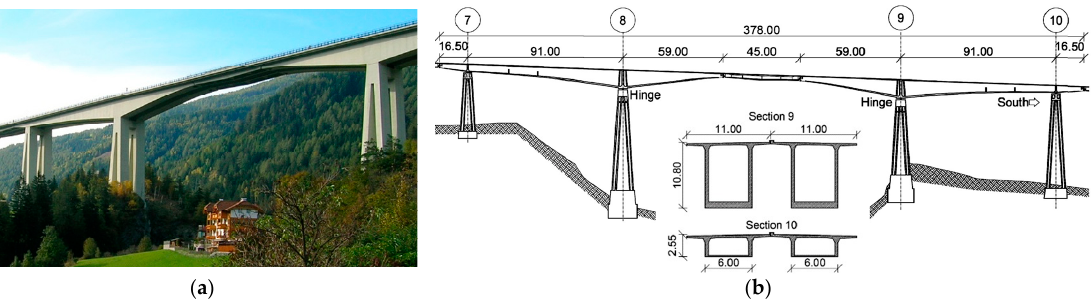
Figure 5. ( a ) The main span and northernmost cantilever of Colle Isarco Viaduct; ( b ) a longitudinal section of the viaduct between piers 7 and 10, and cross-sections of the box girders, with dimensions in meters.